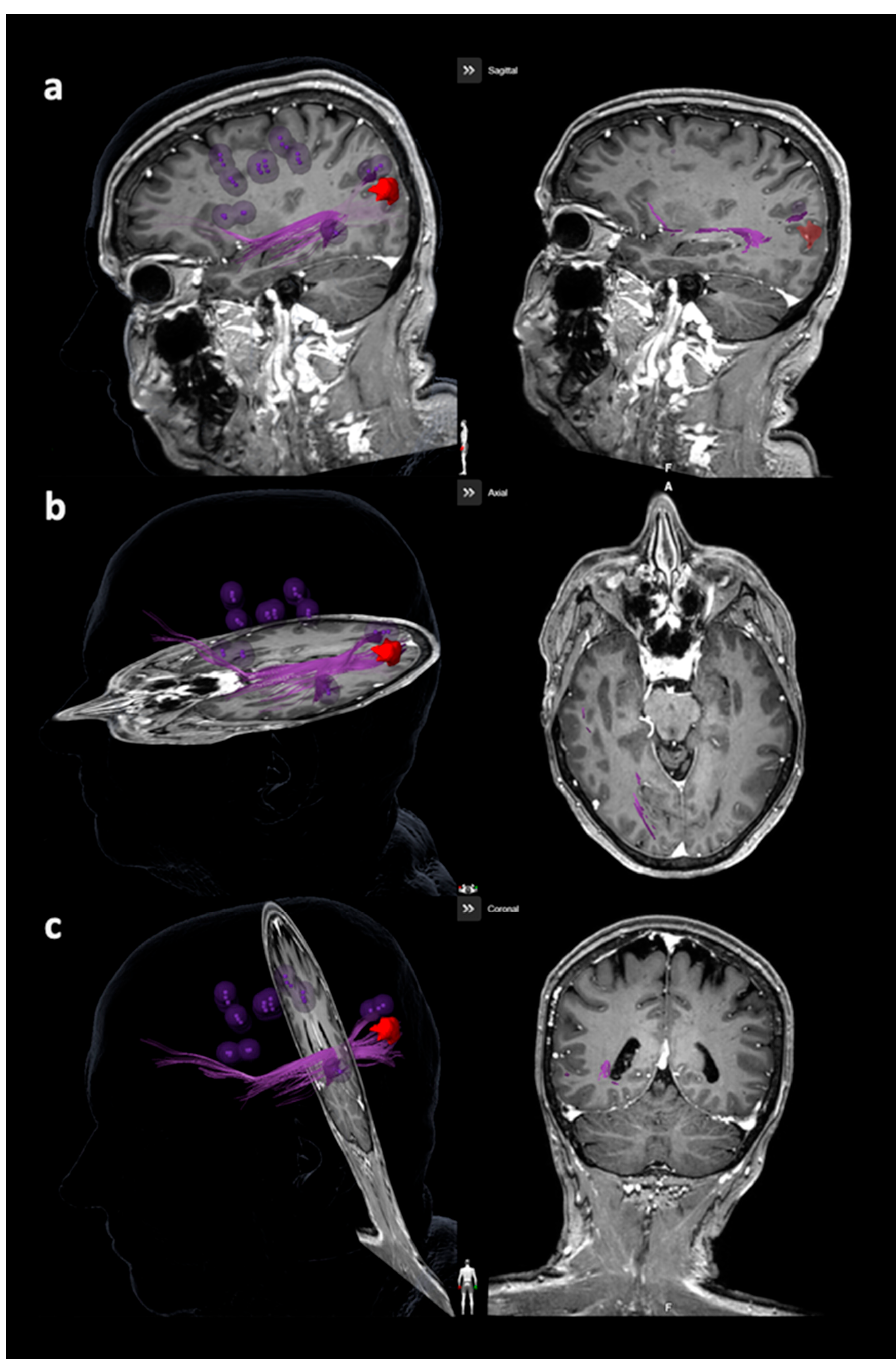
Figure 3. Visualization of the frontooccipital fascicle (FoF). This figure depicts the FoF in purple considering all planes (( a ): sagittal plane, ( b ): axial plane, ( c ): coronal plane), with the reconstruction being purely based on diffusion tensor imaging fiber tracking (DTI FT) using the language map derived from navigated transcranial magnetic stimulation (nTMS). The language map is represented by purple spots, while the tumor volume is enclosed in red.